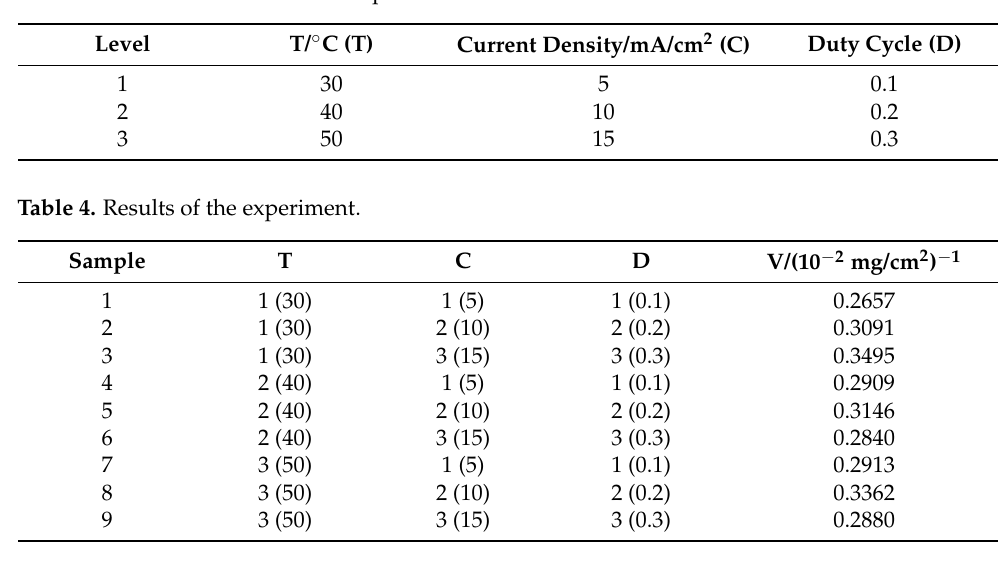
Table 3. Levels and factors of the experiment.